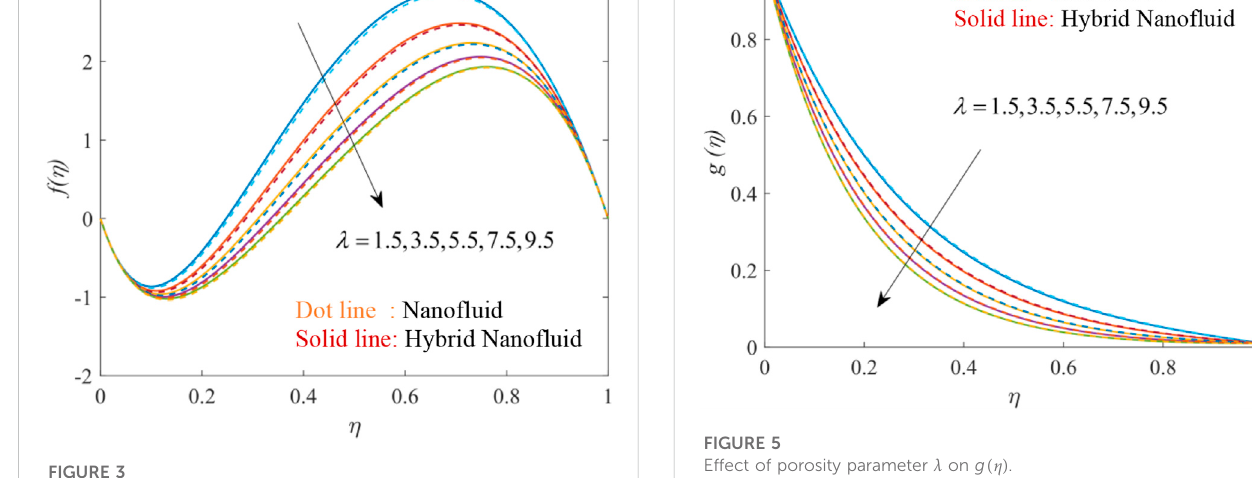
FIGURE 5 Effect of porosity parameter λ on g ( η ) .